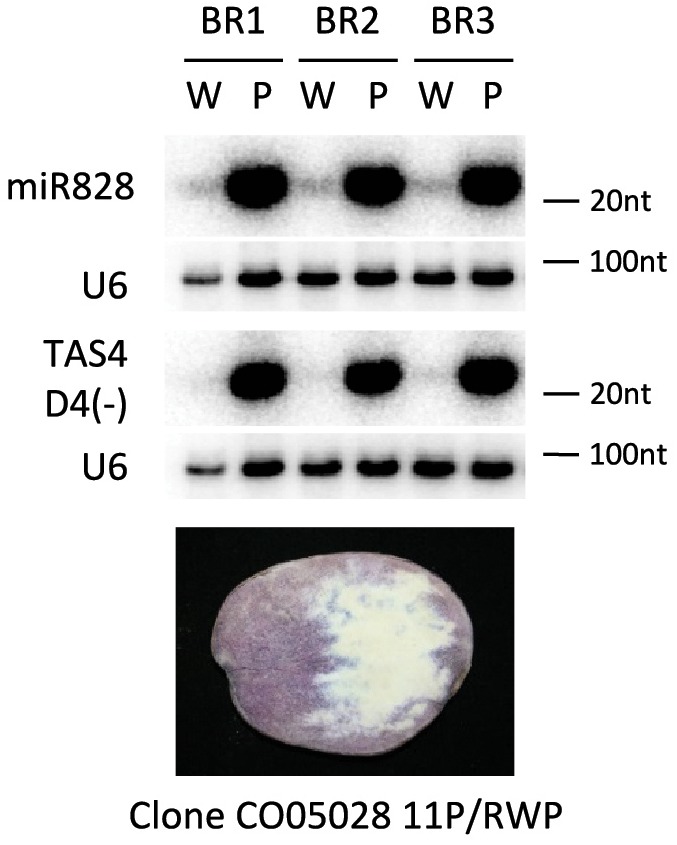
RNA gel blot analysis of small RNAs. Purple (P) and white (W) sectors of clone CO05028 11P/RWP were investigated for the presence of miR828 and TAS4 D4(-) with radioactively labeled probes specific to the small RNAs; U6 was used as a loading control. BR indicates biological replicates.